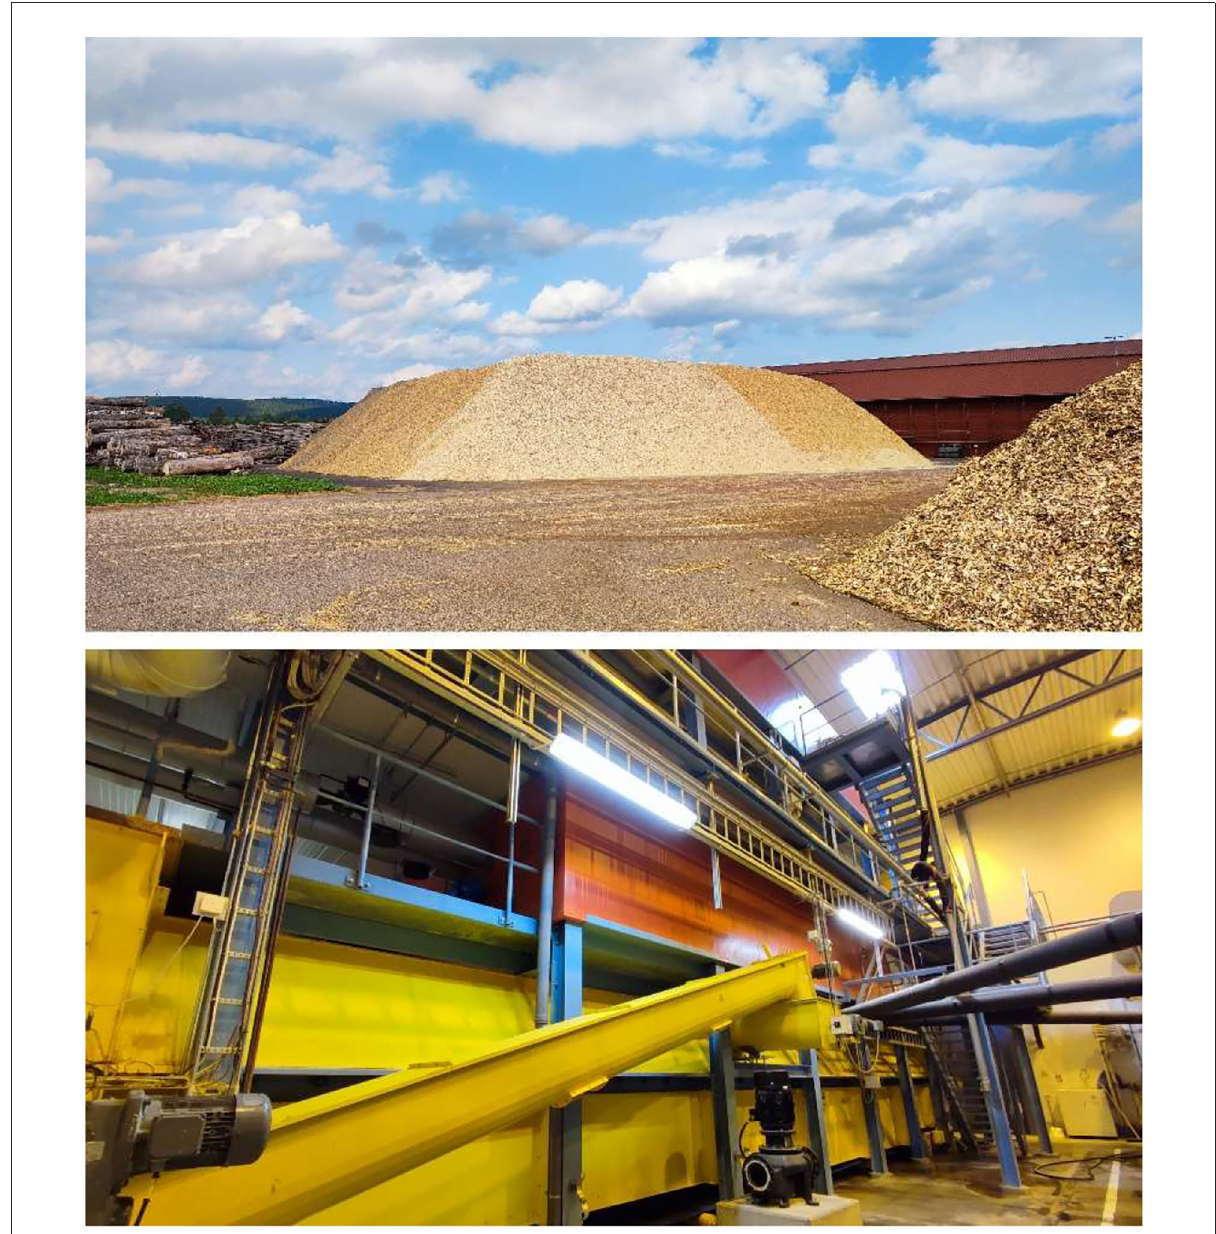
FIGURE4 Large-scale wooden pellet dehydration, partially carried out with data center waste heat from EcoDataCenter, at Falu Energi and Vatten AB. The upper photo shows timber deemed unusable by the forestry industry (left) and therefore destined to become pellets (the two gigantic piles). Photo: P.